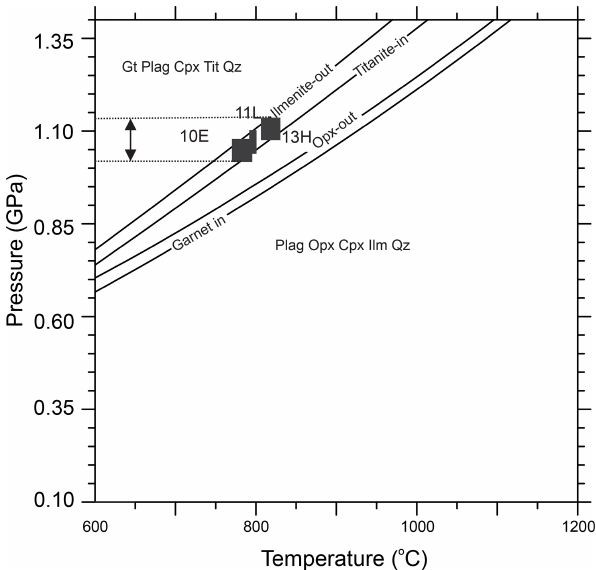
Figure 8. Pseudosection for sample 11L calculated with Theriak- Domino (de Capitani and Brown 1987; de Capitani and Petrakakis, 2010) using the database of Berman et al. (1985). The grey boxes show the estimated temperature for samples 10L, 10E and